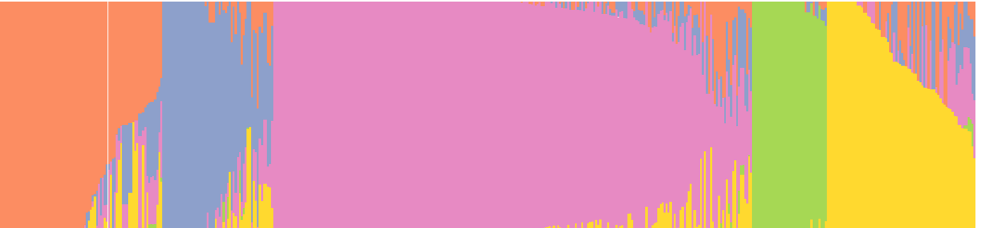
Plants 2022 , 11 , x FOR PEER REVIEW 4 of 13 Figure 1. Distribution of iron (Fe) and zinc (Zn) in barley grains for two crop seasons.